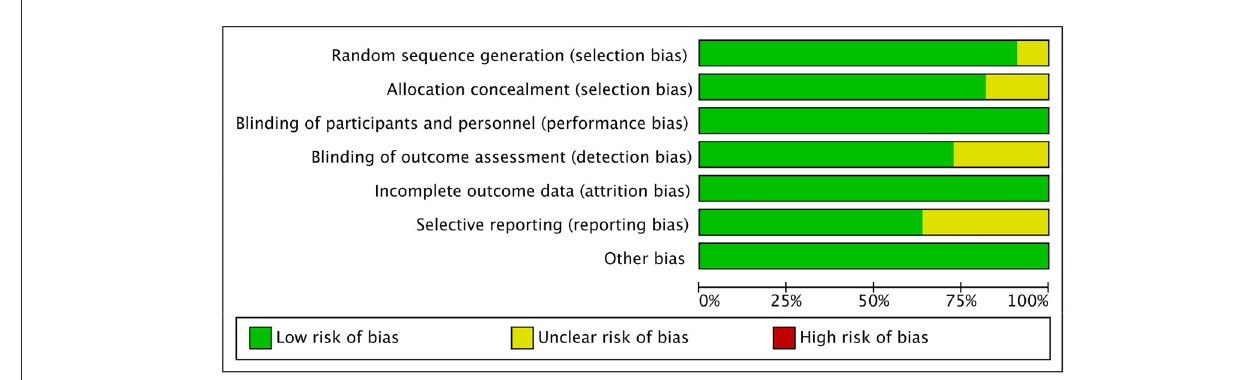
FIGURE2 Risk of bias.